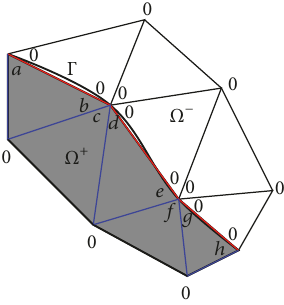
Figure 1: The support and the degrees of freedom of a function 𝜙 ℎ in 𝐵 ℎ (Ω)